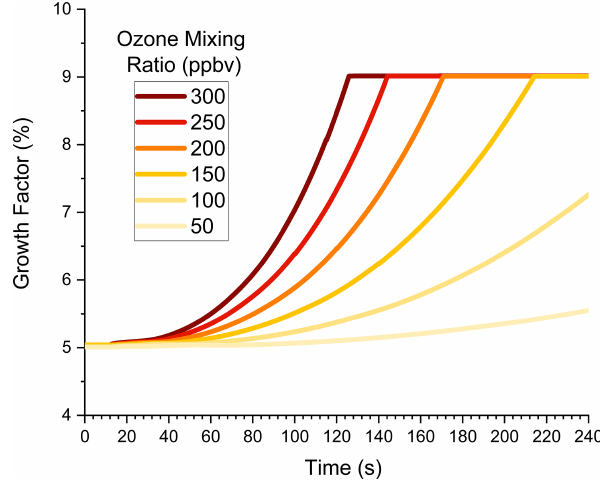
Figure 3. Growth factor vs. time in the flow tube for 40nm ammo- nium sulfate seed particles. Condensation, partitioning, and dimer formation are all included. The ozone mixing ratio is shown with increasing colour intensity corresponding to an increasing mixing